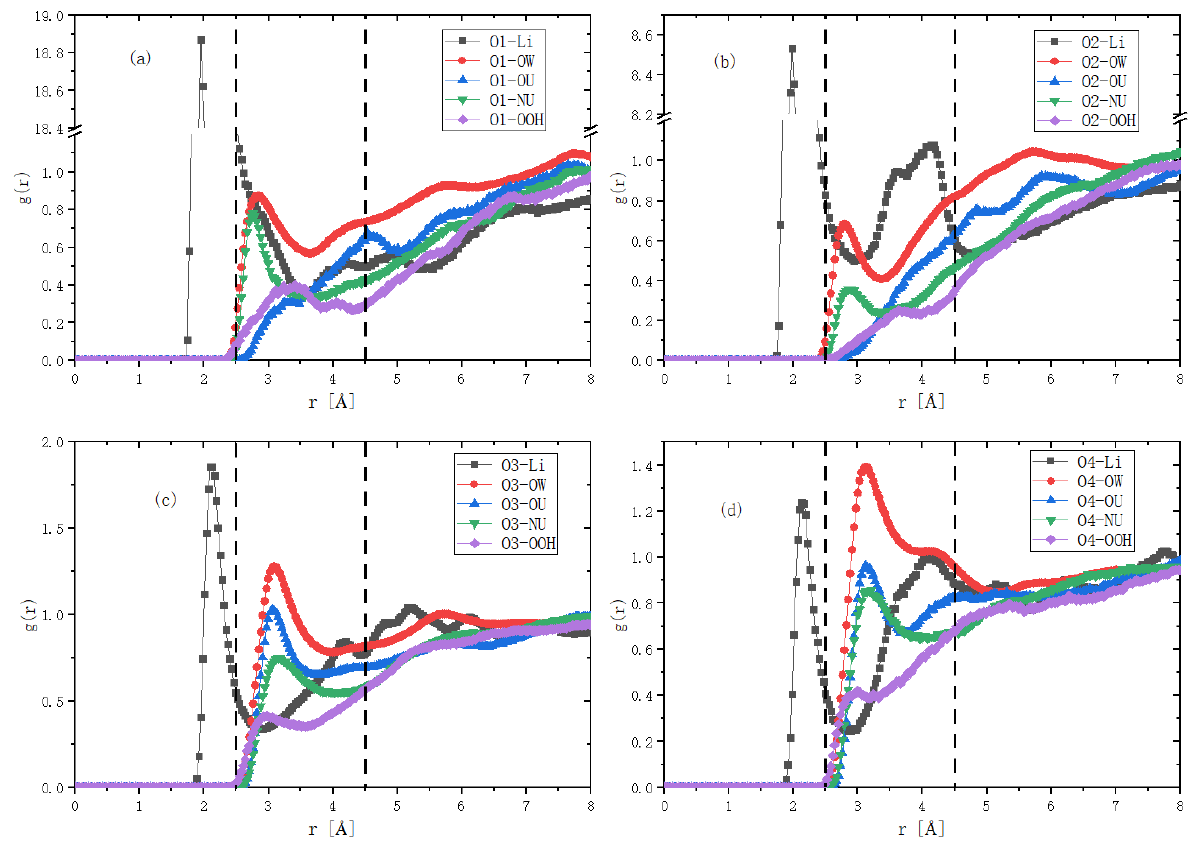
Figure 5. RDF distributions of some solvent atoms, i.e., Li, OW, OU, NU and OOH, around Os atoms in trehalose LiOH urea aqueous solution. ( a – d ) is the RDF distribution around O1 to O4, respec- tively. The dashed lines are used to indicate the boundary of the second hydration shells.